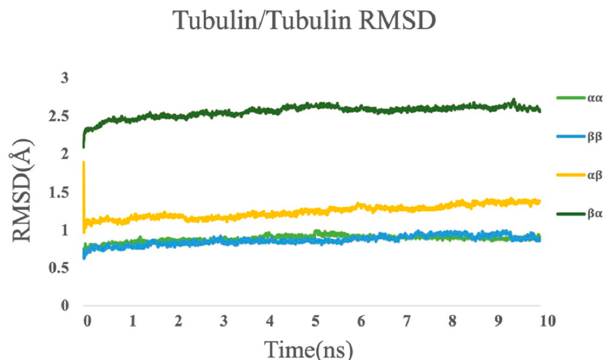
Figure 6. RMSD plot of tubulin complexes for α / α tubulins, β / β tubulins, α / β tubulins, and β / α tubulins.